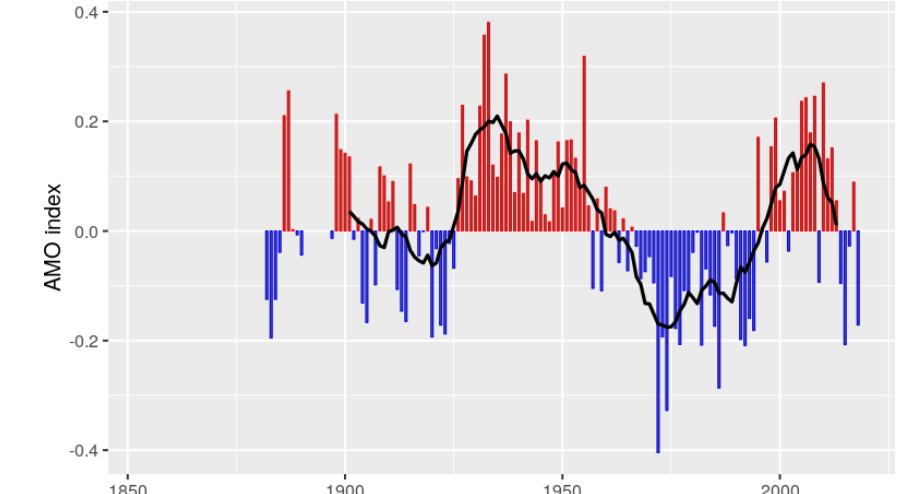
Figure 6. Normalized annual mean AMO index during 1882–2018. Red – positive; blue – negative; black – 10-year running mean. The normalisation is the (data mean (data))/standard deviation (data). Data source: https://climexp.knmi.nl/data/iamo_hadsst_ts.dat (last access: 17 February